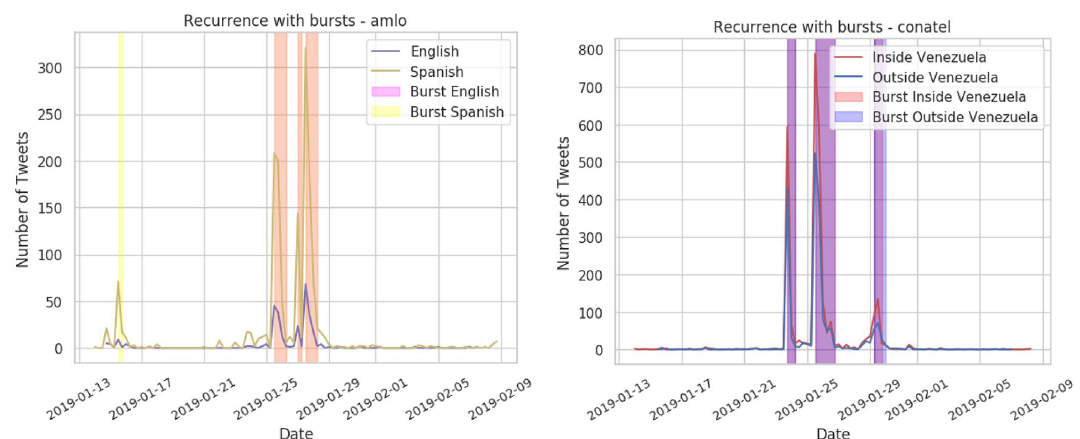
Figure 4. Time series of tweet counts related to specific example units of information with detected burst periods highlighted. The time series are broken down by language (left) and user location (right). For language, we show how “AMLO” (the nickname for the President of Mexico, Andrés Manuel López Obrador) bursts across Spanish Twitter (yellow) and English Twitter (purple), with orange bars indicating simultaneous bursts in both communities. For location, we show how “Conatel” (the National Commission of Telecommunications in Venezuela) bursts inside (red) and outside (blue) of Venezuela, with purple bars indicating simultaneous bursts in both communities.